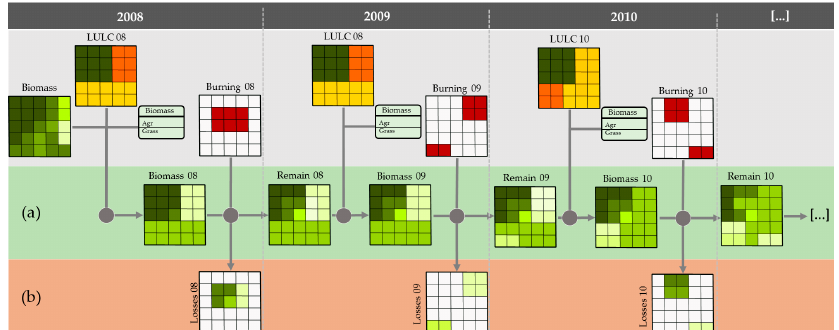
Figure 1. Workflow for generating the annual maps of remaining and loss of biomass. ( a )The green panel represents the 2008–2010 annual potential biomass maps, which were processed from the annual burned area maps; 2008, 2010, and 2012 land use and land cover (LULC) maps; and a table of reference biomass values for each grouped LULC classes. ( b ) The red panel represents the 2008–2010 annual biomass loss maps, derived from an empirical relationship between pre and post-fire biomass applied to the potential biomass maps where a fire event was depicted by the burned area maps. Finally, to quantify the total annual gross carbon emissions, we applied the CO 2 gross emission model (Equation (1)) to the biomass loss maps (Figure 1b).